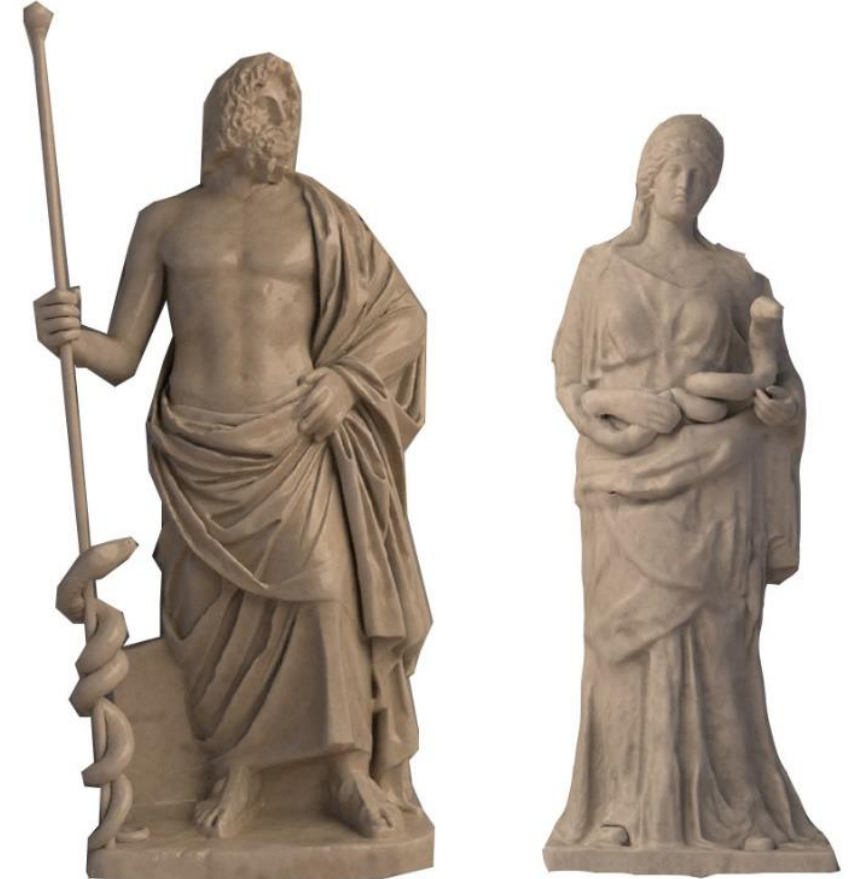
Figure 12. Rendering of the low poly models of the Aesculapius and Hygeia statues .